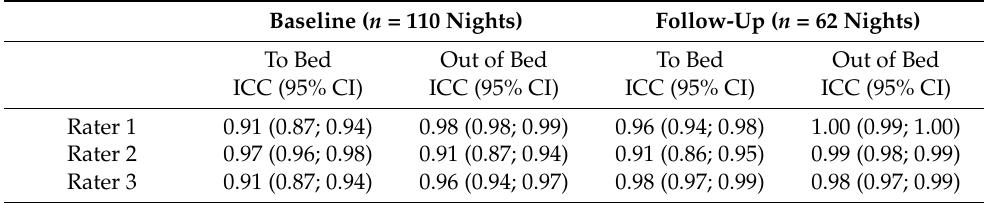
Table 6. Test–retest intraclass correlation coefficients between the first and second round of manual